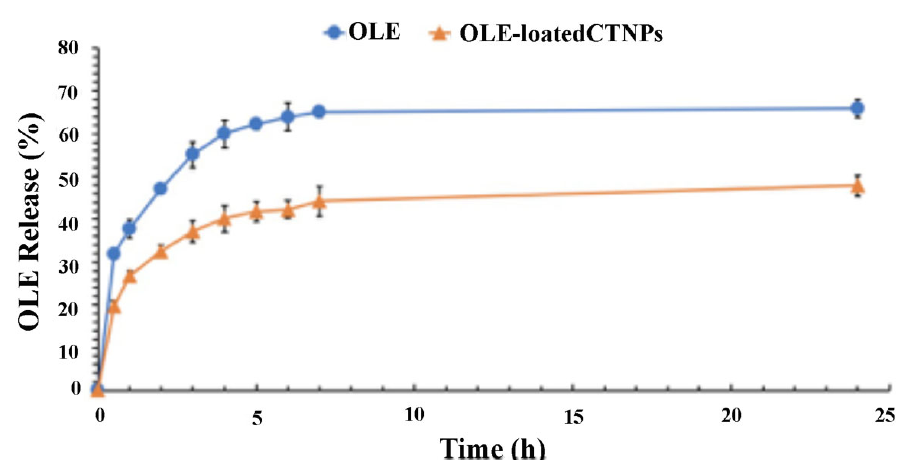
Figure 3. In vitro OLE release in phosphate buffer pH 5.9 at room temperature from OLE ‐ loaded CTNPs ( ▲ ), and OLE solution ( • ). In all of the cases, each value represents the mean ± SD of three independent experiments.